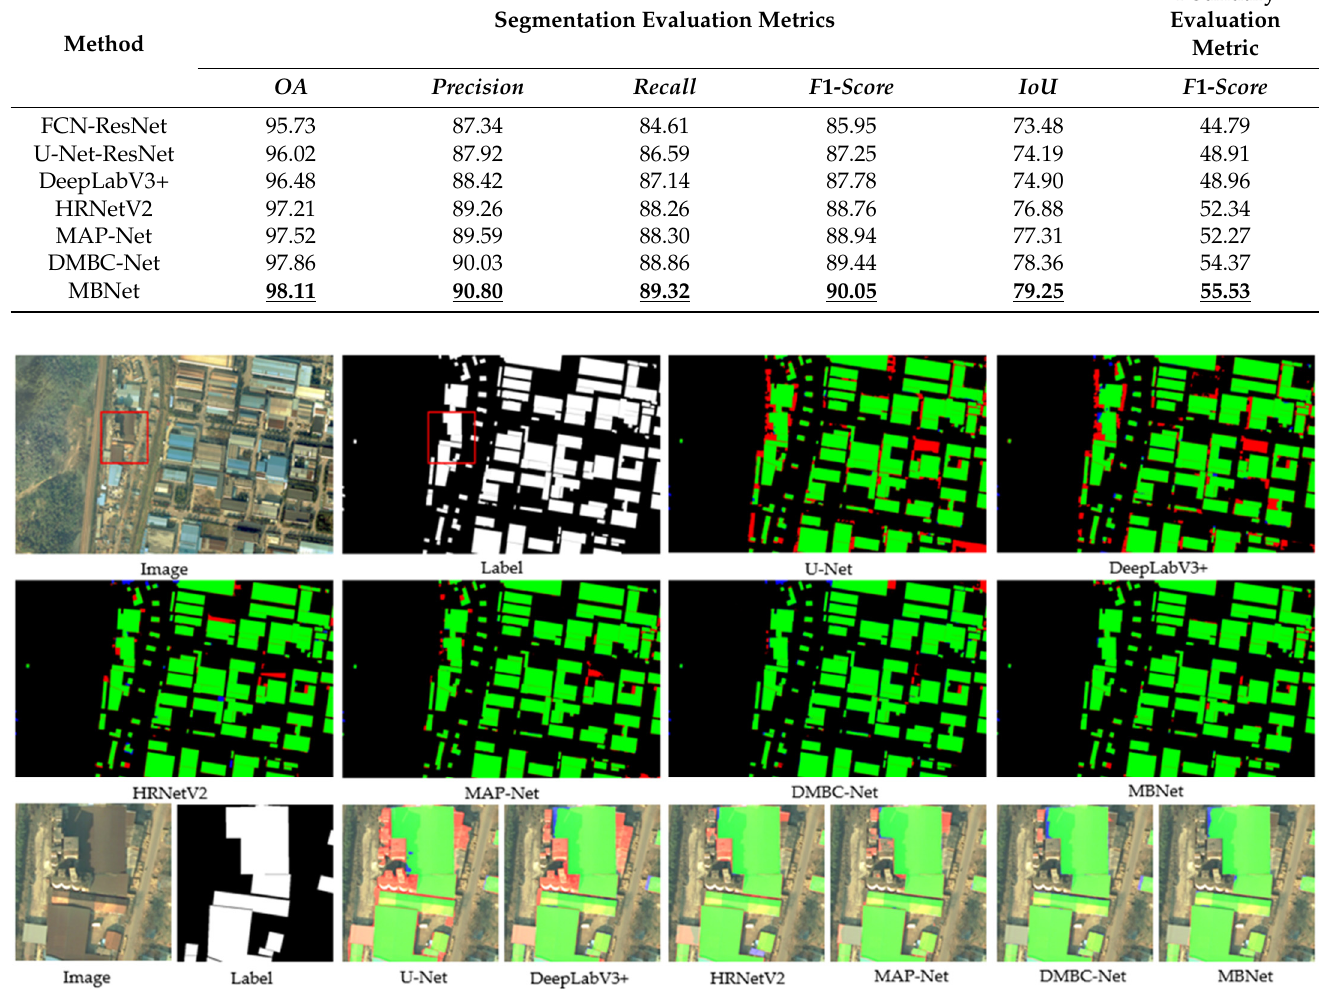
Figure 15. Segmentation results of the different SOTA methods on the suburban dense area scene 1 test dataset. The bottom row is a close-up view of the red box.